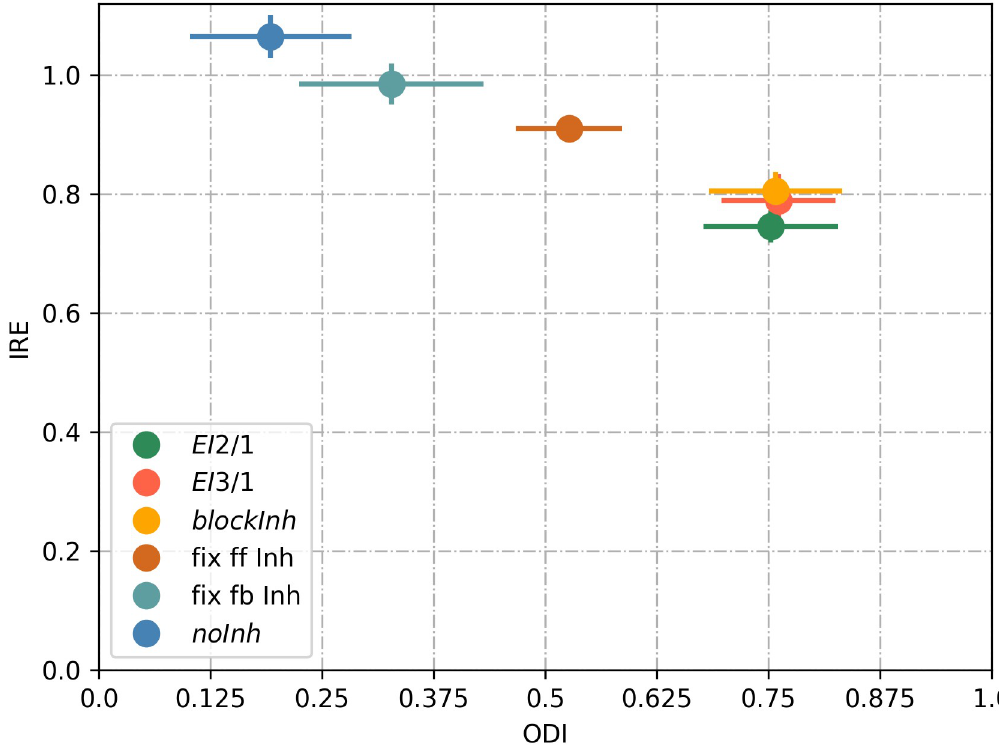
Fig 10. Plastic inhibition during learning improves input encoding quality via higher orientation diversity. Image reconstruction error (IRE) as a function of the orientation diversity index (ODI), for the EI 2/1 model (green dot),the EI 3/1 model (red dot), the blockInh model (orange dot), model with fixed feed-forward inhibition (brown dot), model with fixed feedback inhibition (light blue dot), and the noInh model (dark blue dots). IRE is calculated as the mean-square error between input image and the reconstruction. A better reconstruction is represented by smaller values for the IRE and is associated with a higher orientation diversity (presented by higher ODI values). Data shown from 20 independent simulations per model